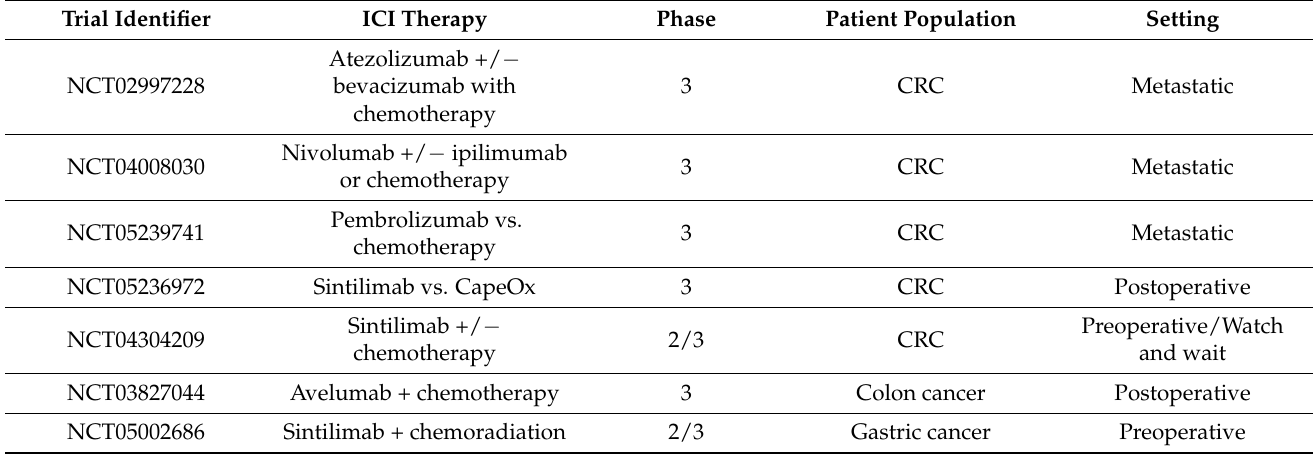
Table 1. Microsatellite Instability-High/Deficient Mismatch Repair (MSI-H/dMMR) Phase 3 Trials in Gastrointestinal Malignancies